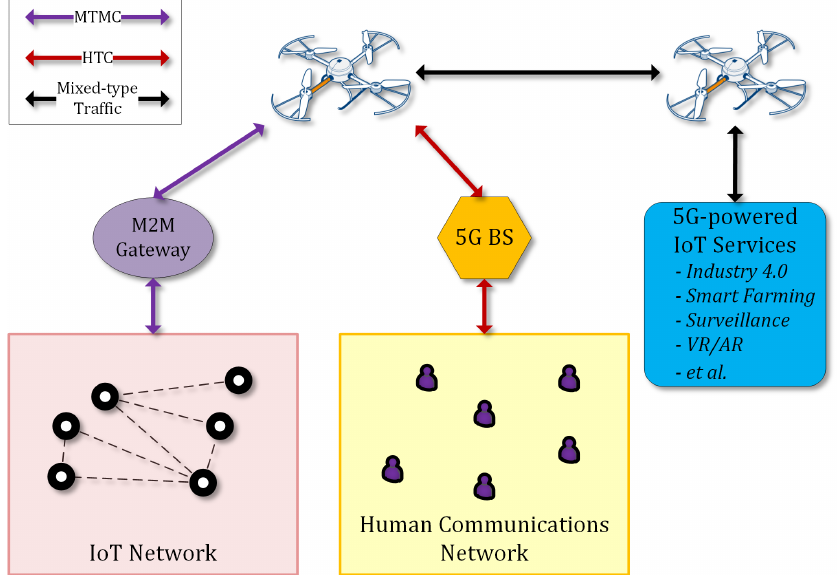
Figure 1. Unmanned aerial vehicle (UAV)-enhanced 5G-enabled Internet of Things (IoT)